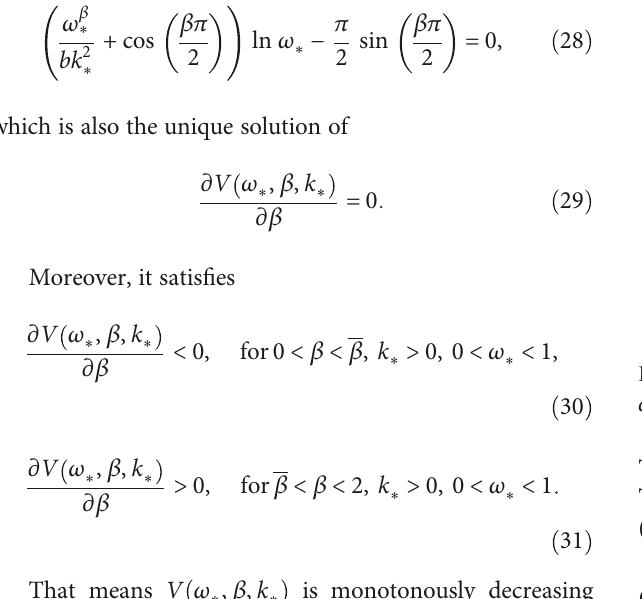
Figure 3: Diagram between V ω ω 2 2 ∗ / bk ∗ = 6 25 .